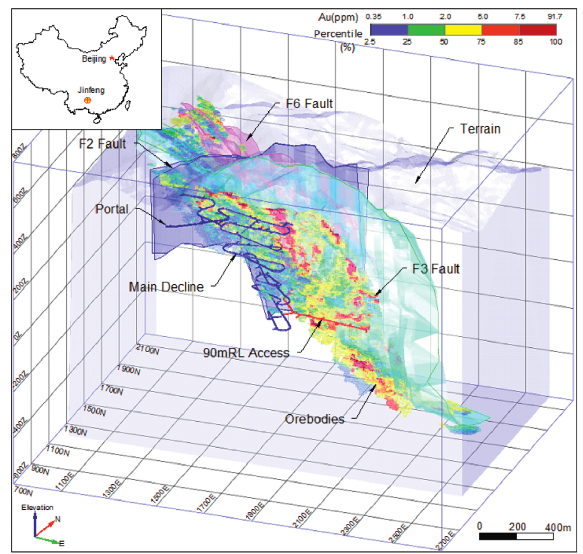
Figure 1: The location of Jinfeng gold mine and the main